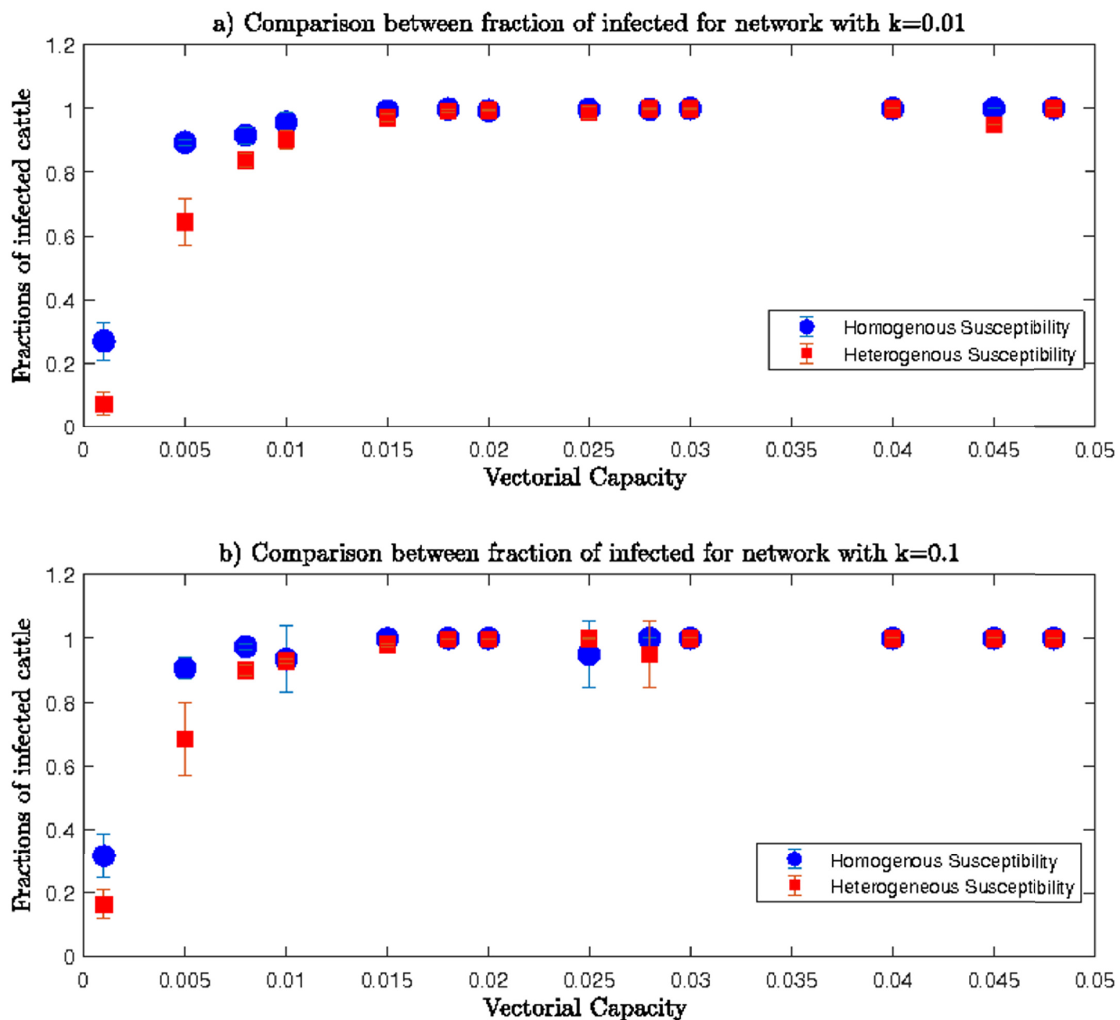
Fig 9. Comparisons among fractions of infected cows for heterogeneous and homogenous networks for the upper range of β and a) k = 0.01 and b) k = 0.1.